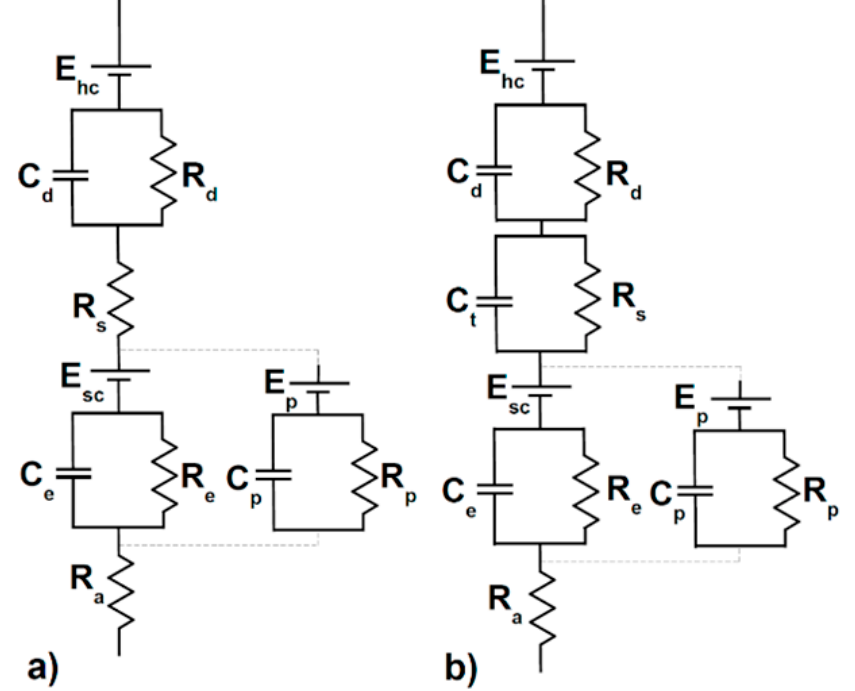
Figure 3. Equivalent circuit of the interface between skin and electrodes in the case of ( a ) wet electrodes and ( b ) textile electrodes. The figure was adapted from [27]. E hc represents the electrode; C d and R d represent the impedance due to the sensor-electrolyte interface; C t (only present in textile electrodes) and R s represent an impedance due to the electrolyte layer; C e and R e represent the middle-layer impedance; C p and R p represent the sweat glands; R a represents the inner-layer impedance, acting as a pure resistance in both cases.